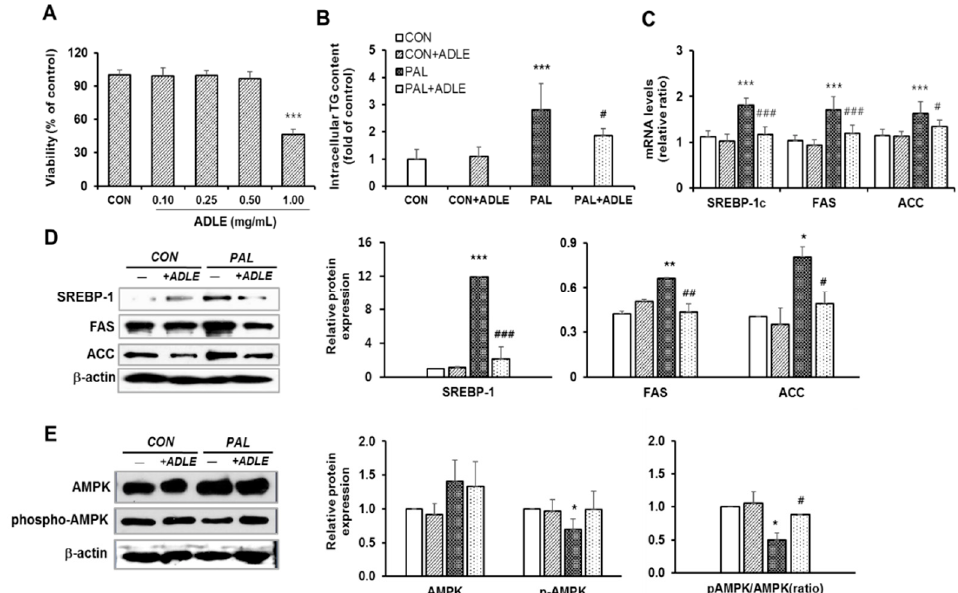
Figure 6. ADLE reduced lipogenic gene expression in palmitate-treated HepG2 cells. ( A ) HepG2 cells were cultured with various concentrations of ADLE for 24 h and cell viability was determined by MTT assay. ( B ) HepG2 cells were treated with 0.5 mM palmitate (PAL) with or without ADLE (0.5 mg / ml) for 24 h and the intracellular TG levels were measured by triglyceride assay kit. ( C ) The cells were treated as described in Figure 6B, and mRNA levels (SREBP-1c, FAS, and ACC) were determined by qRT-PCR analysis. The mRNA levels were normalized with those of cyclophilin. ( D ) Protein expression levels of SREBP-1, FAS, and ACC were measured by western blot analysis. ( E ) Protein expression levels of AMPK and phospho-AMPK were measured by western blot analysis. The intensity of each band was measured with Quantity one software, and the relative quantity was calculated over β -actin. The results are expressed as the mean ± SD ( n = 3–5). * p < 0.05, ** p < 0.001, and *** p < 0.001 vs. untreated control (CON). # p < 0.05, ## p < 0.001, and ### p < 0.001 vs. 0.5 mM PAL only.